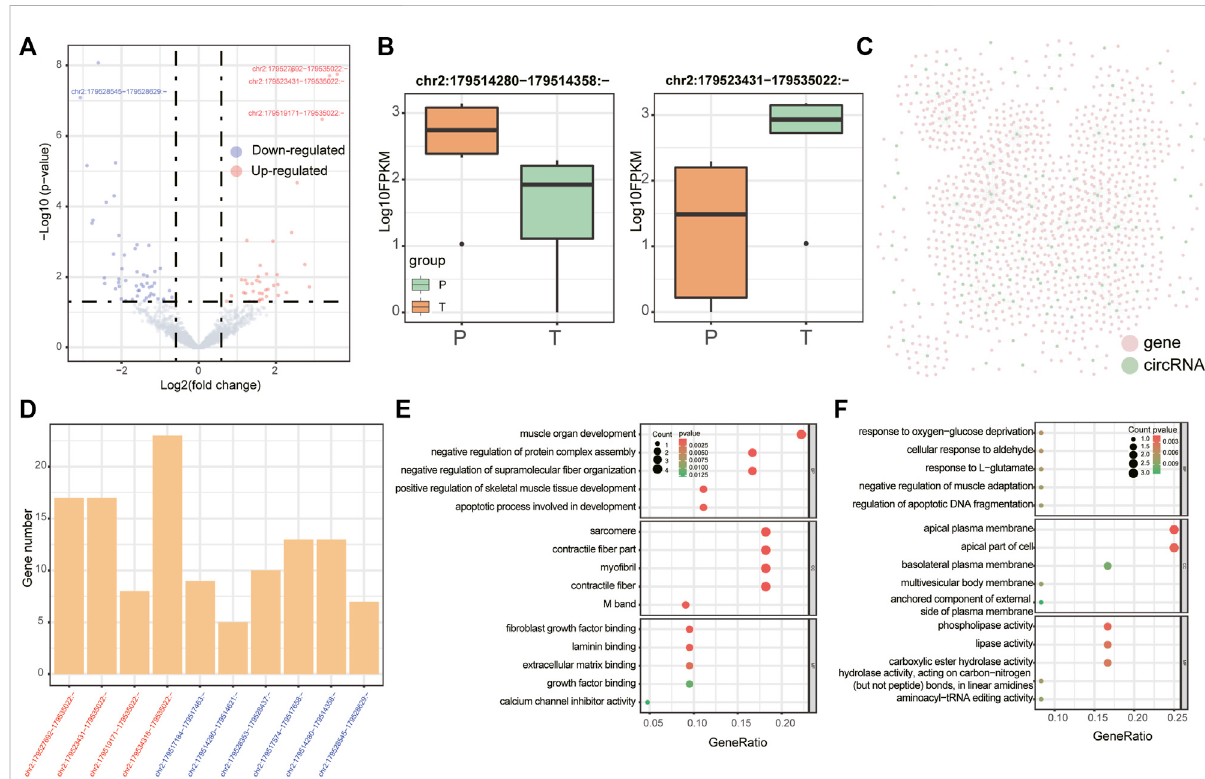
FIGURE 3 Differentially expressed circRNAs. (A) Volcano plot of differentially expressed circRNAs in RCT. Red points denote up-regulated circRNAs, and blue points denote down-regulated circRNAs. The most up- or down-regulated circRNAs are labeled. (B) Boxplots denote expression levels of 2 differentially expressed circRNAs which were derived from TTN ( chr2:179514280 – 179514358:- (left panel) and chr2:179523431 – 179535022:- (rightpanel)). (C) Co-expressionnetworkofdifferentiallyexpressedcircRNAs.PinkpointsdenotemRNAsandgreenpointsdenotecircRNAs. (D) Barplots denote the numbers of mRNAs regulated by circRNAs that were produced by TTN in the co-expression network. CircRNAs were ordered according to the fold changes in group T vs. group P (all circRNAs were identi fi ed both by edgeR and by GLMM). (E,F) GO enrichment analysis for all co-expressed mRNAs of chr2:179534318 – 179535022:- and chr2:179514280 – 179514358:-